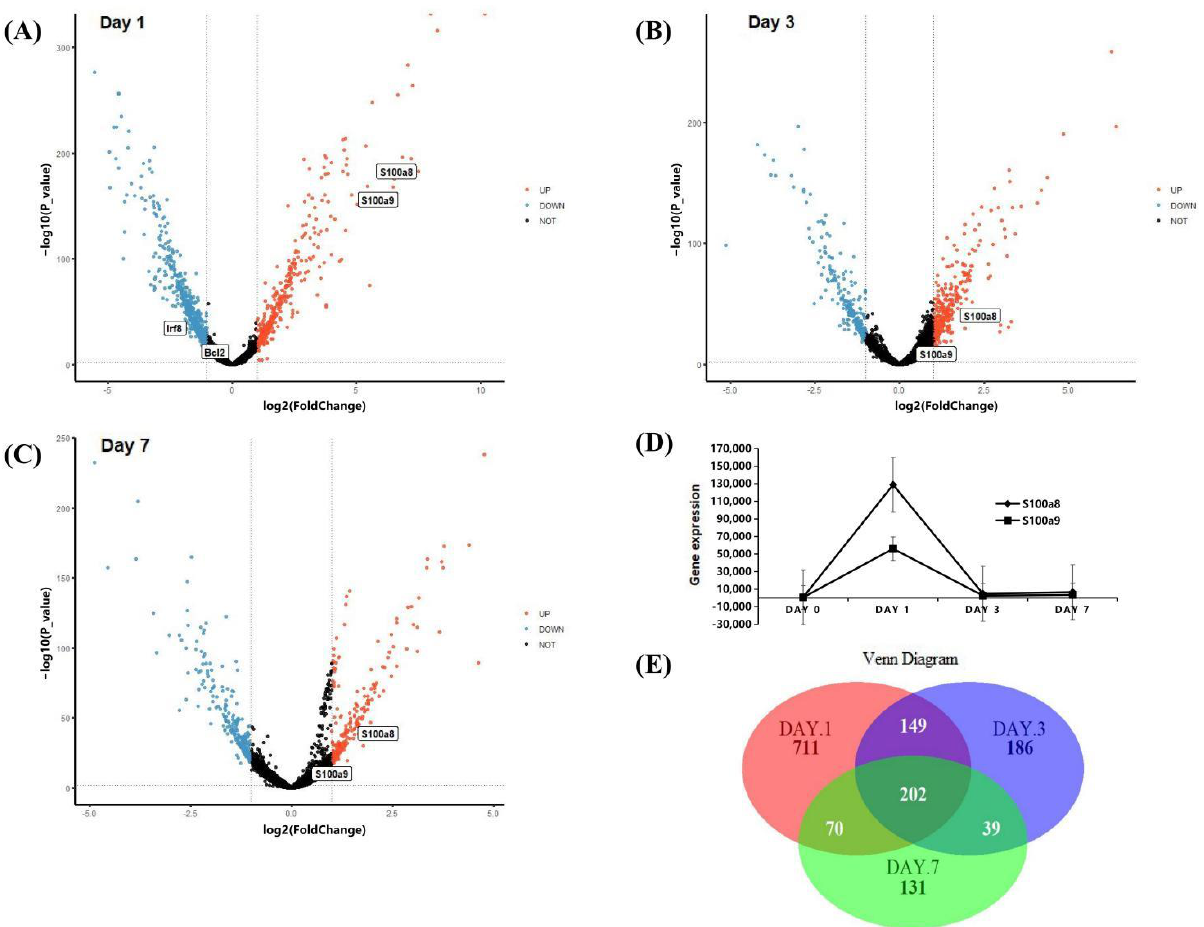
Figure 2. DEGs analysis of scRNA-seq data. ( A ) Volcano plot of changes in CD45+ total leukocyte gene expression in the heart on day 1 post-MI; and ( B ) for day 3 post-MI; ( C ) for day 7 post-MI. Red dots denote genes with log2 FC > 1 and p < 0.05; blue dots denote genes with log2 FC < − 1 and p < 0.05. ( D ) Line chart of S100a8 and S100a9 expression change after MI in the scRNA-seq data. The diamond line represents S100a8, and the square line represents S100a9. ( E ) Venn diagrams of significant DEGs detected in infarct group vs. normal group at 1, 3, and 7 days post-MI. After normalization and standardization of the obtained scRNA-seq data, a total of 666 cells were obtained on day 0, 528 cells on day 1, 943 cells on day 3, and 1796 cells on day 7, with 27,998 genes per cell (Figure 3A). Subsequently, we grouped daily cells based on gene expression profiles, and t-distributed stochastic neighbor embedding (t-SNE) plots were taken for visualization. According to the expression of neutrophil markers (Hp, G0s2) and macrophage markers (Cd68, Il1b, Lyz1, Cd74) [23,24], we divided the cells at each time point into three categories: neutrophils (red), macrophages (blue), and unknown (gray). After MI, the number of neutrophils increased greatly and reached a peak on day 1 post-MI, accounting for 41.10% of the total number of CD45+ cells (Figure 3B). After the third day, neutrophils gradually decreased, and other cells, such as T/B lymphocytes, NK cells, and endothelial cells, increased conversely, making up 68.10% (Figure 3B). It is worth noting that the change in the proportion of neutrophils was similar to the change in the expression level of S100a8 and